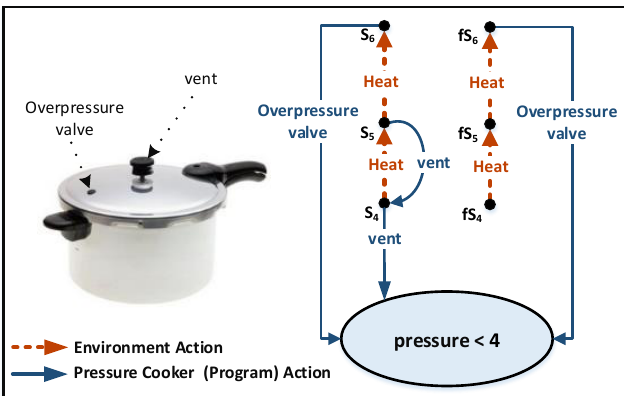
Figure 1. An intuitive example to illustrate the role of environment actions. We want the pressure to be always less than 4. The program captures the behavior of the pressure cooker including the vent and the overpressure valve. The environment captures the behaviors of the heat source. The environment can be disruptive for the venting mechanism. It is, however, essential for the overpressure valve to be activated. For the sake of readability, only transitions relevant to the discussion are shown in the